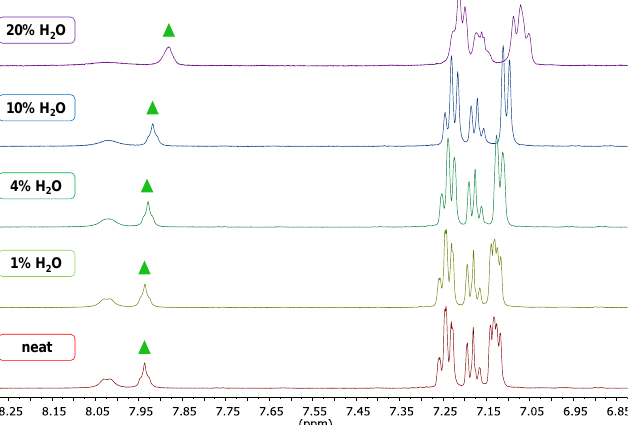
Figure 3. Partial 1 H NMR (500 MHz, DMSO- d 6 ) spectra for the titration of 6b (3 mM) with increasing amounts of water. The water content is indicated as v / v (%). The signal for the central amide groups has been marked with green